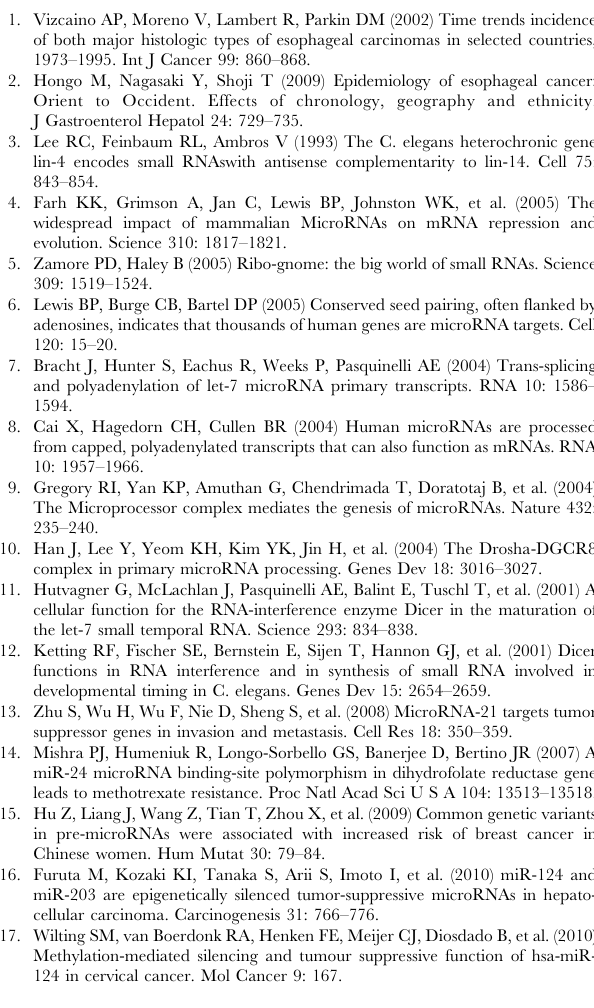
Table S1 Primers used in SNP genotyping procedure.